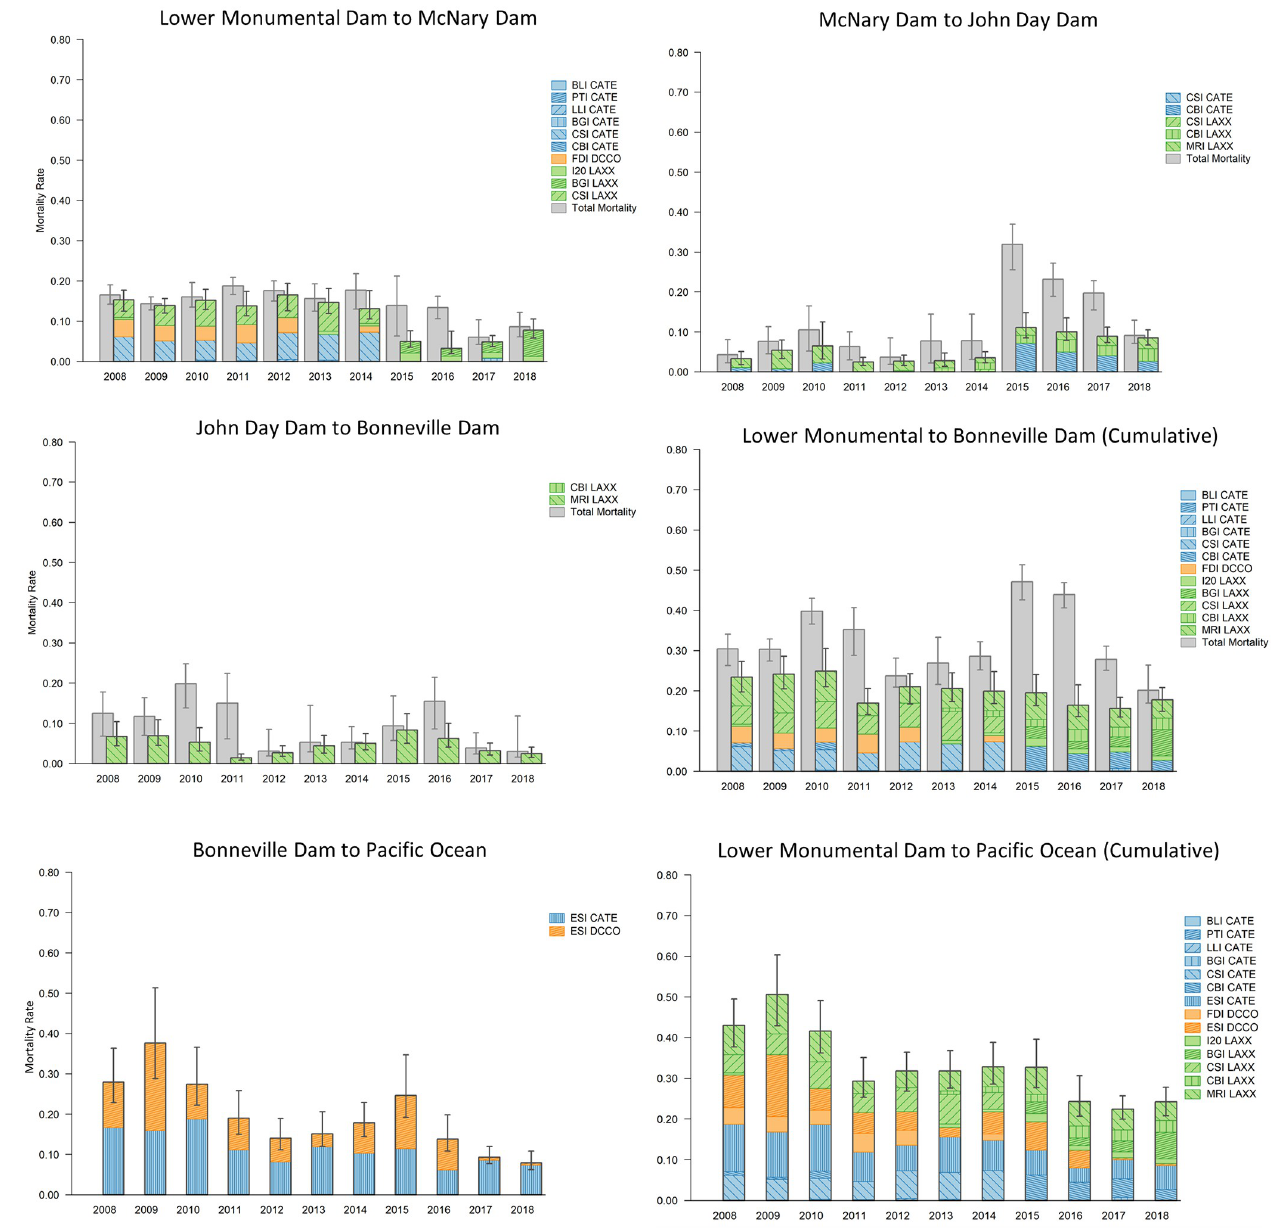
Fig 2. Avian consumption and total mortality of snake river steelhead. Estimated annual reach-specific and cumulative avian consumption probabilities (colored bars) and total mortality (grey bars) of Snake River steelhead trout smolts during passage from Lower Monumental Dam on the Snake River to the Pacific Ocean. Piscivorous waterbird colony locations include Banks Lake Island (BLI), Potholes Reservoir (PTI), Lenore Lake Island (LLI), Island 20 (I20), Foundation Island (FDI), Badger Island (BGI), Crescent Island (CSI), central Blalock Islands (CBI), Miller Rocks Island (MRI), and East Sand Island (ESI). Avian species include Caspian terns (CATE), double-crested cormorants (DCCO), and California and ring-billed gulls (LAXX). Error bars represent 95% credible intervals for total mortality and avian